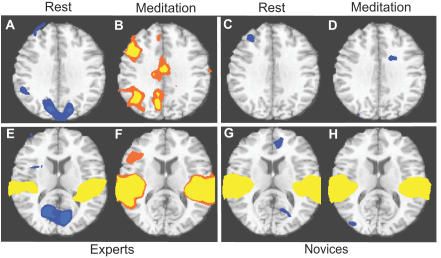
Directionality of the brain activation.Areas showing a negative ( dark blue, p<0.01, blue, p<0.005) or positive (orange, p<0.01, yellow, p<0.005) impulse response on average across 10 seconds in responses to all emotional sounds for the 15 novices and 15 experts at z = 31 compared to baseline (figs. A–D) and z = 13 (figs. E–H) (voxel-by-voxel paired t test compared to 0, corrected at p<0.01).